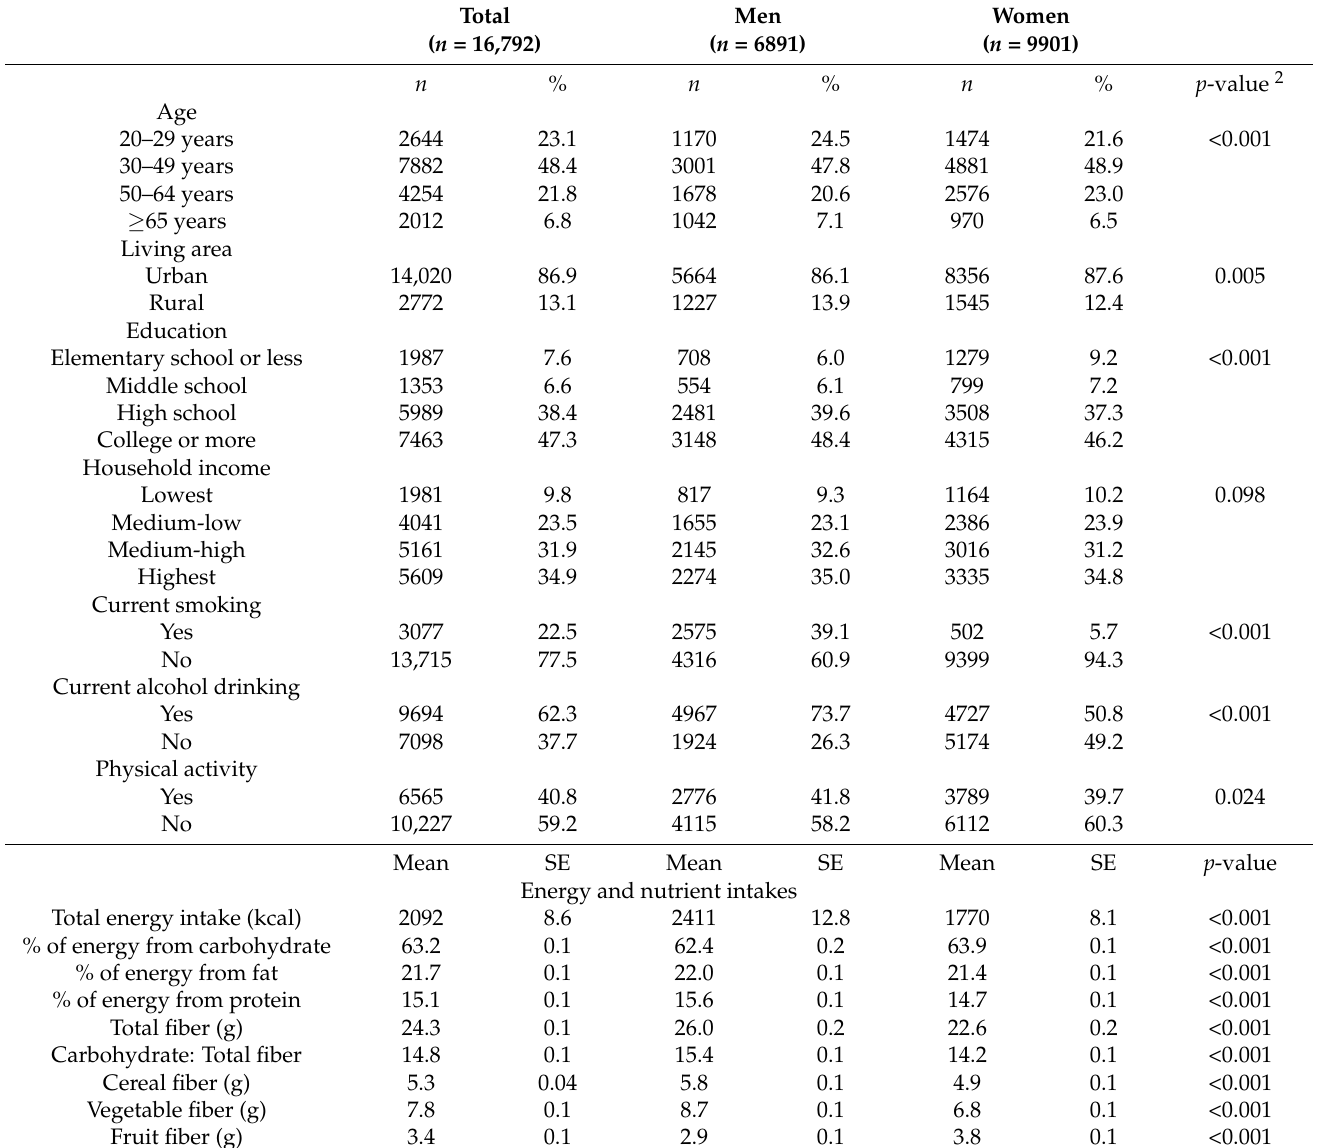
Table 1. Characteristics of the study subjects by sex 1